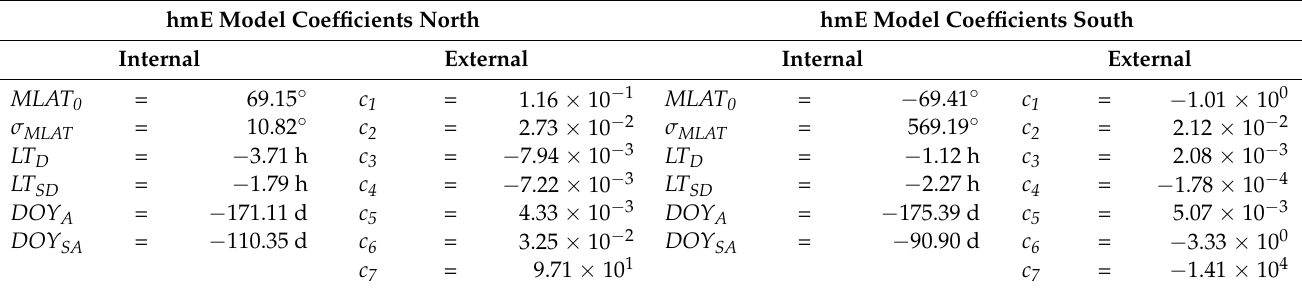
Table 3. Coefficients of the E layer peak height (hmE) model for the Northern and Southern Hemispheres. hmE Model Coefficients